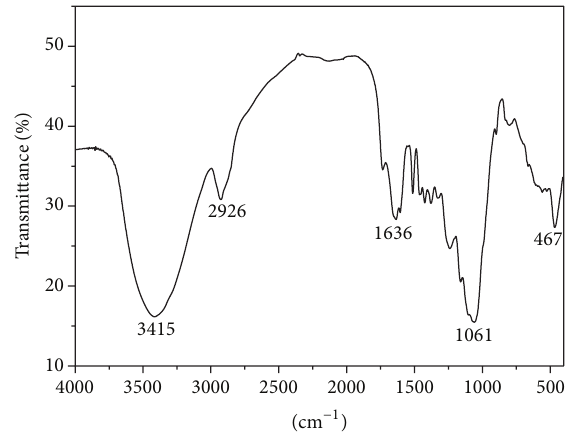
Figure 6: IR transmittance spectrum versus cm −1